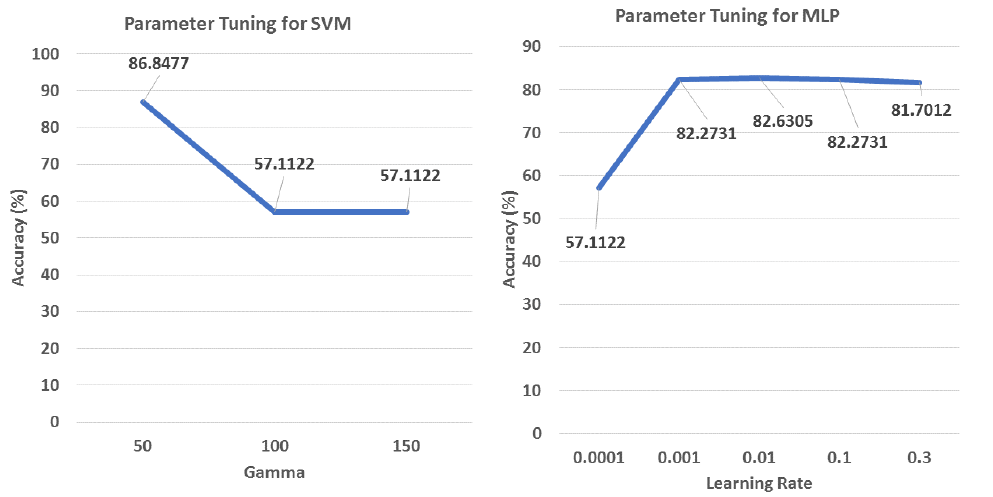
Figure 13. Parameter Tuning for SVM and